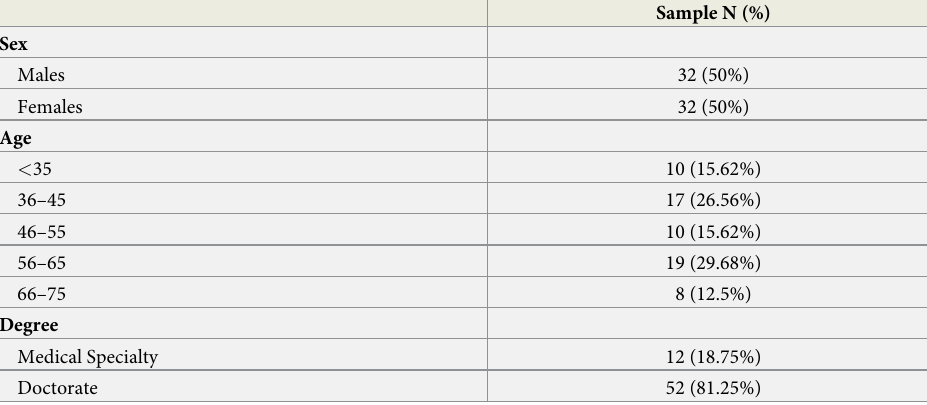
Table 1. Demographics of the